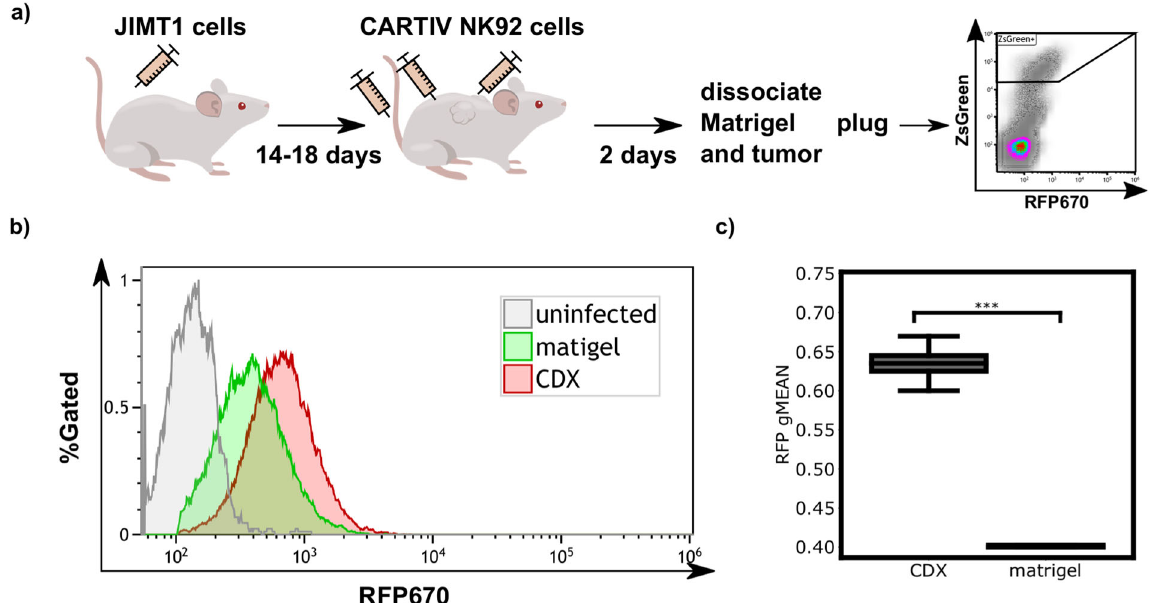
Fig. 7 The G1K06H1 CARTIV promotor is induced in the tumor microenvironment. a Schema of the experimental setup used to test the G1K06H1 promotor in vivo. b Representative FACS plot of the RFP670 reporter of ZsGreen positive cells injected subcutaneous or intratumoral. Data are single- discriminated and DAPI-negative results. c Summary of reporter expression in the CDX compared with the Matrigel plug in 6 mice; exclusion criterion was less than 500 cells detected. Number of tested tumors is eight; a t -test was performed, box borders represent upper and lower quartiles. Solid lines represent the median and dashed line the mean. Whiskers represent maximum and minimum. * P -value < 0.05; ** P -value < 0.005; *** P -value <